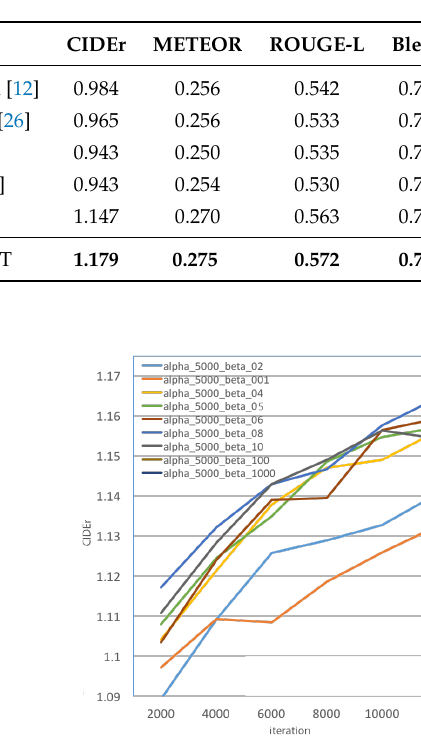
Table 2. Automatic evaluation on the online official MSCOCO [8] test split.